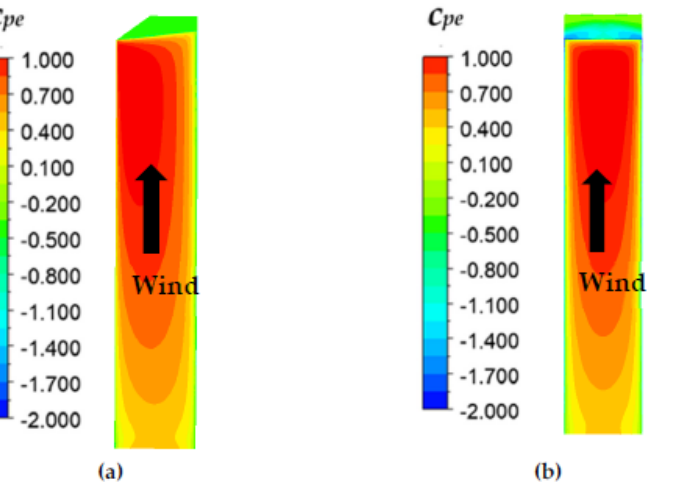
Figure 11. Mean external pressure coefficients (wind direction 45°). ( a ) Atypical structure; ( b ) the cuboid.